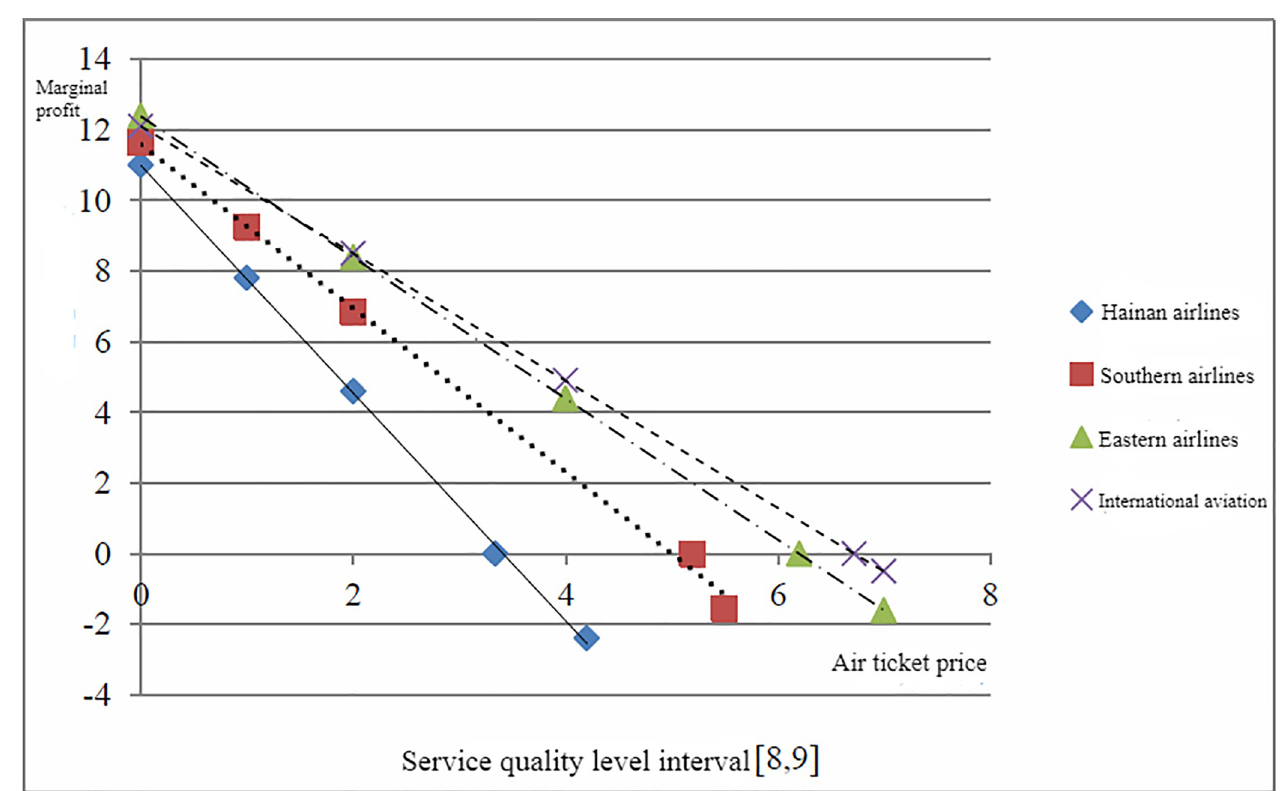
Fig 4. High-level service quality level fare